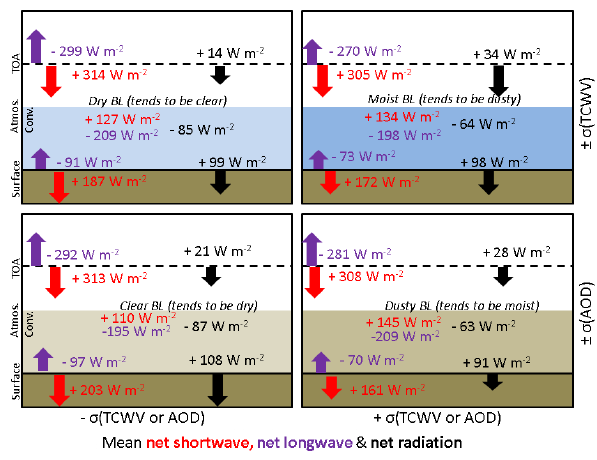
Figure 5. Schematic showing net radiation and implied tropo- spheric radiative heating, in situations where either TCWV (top row) or AOD (bottom row) is perturbed by plus or minus one stan- dard deviation away from their mean state (right and left columns respectively). Moist atmospheres tend to be dusty and vice versa. Red numbers show net shortwave, purple numbers show net long- wave and black show net radiation. TOA and surface heating are shown by plus signs with downward arrows. Values are shown at surface, TOA and for inferred atmospheric radiative heating (“At- mos. Conv.”). Variance in TCWV has the dominant effect on net TOA radiation, while variance in AOD has the dominant effect on net surface radiation. Both TCWV and AOD are important for at- mospheric heating